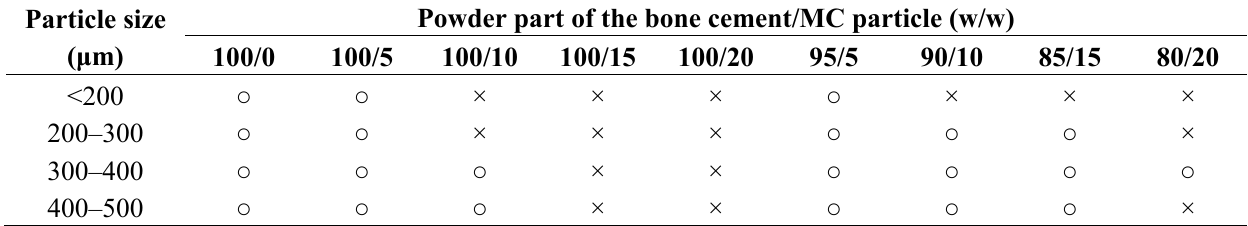
Table 1. The injectability of the MC modified Osteopal ® V bone cement.